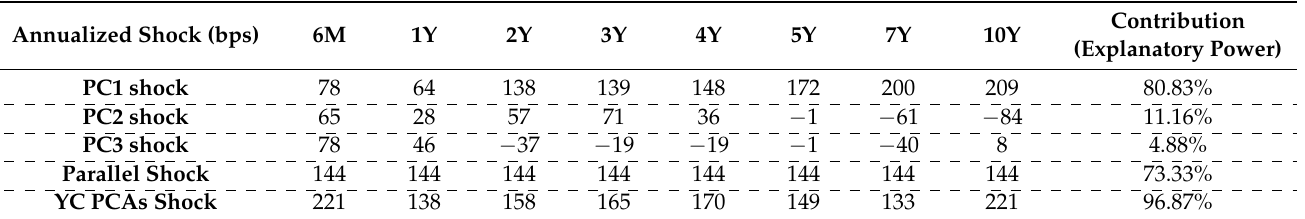
Table A2. Likelihood of principal components’ annualized yield curve shocks on 25 March 2022.